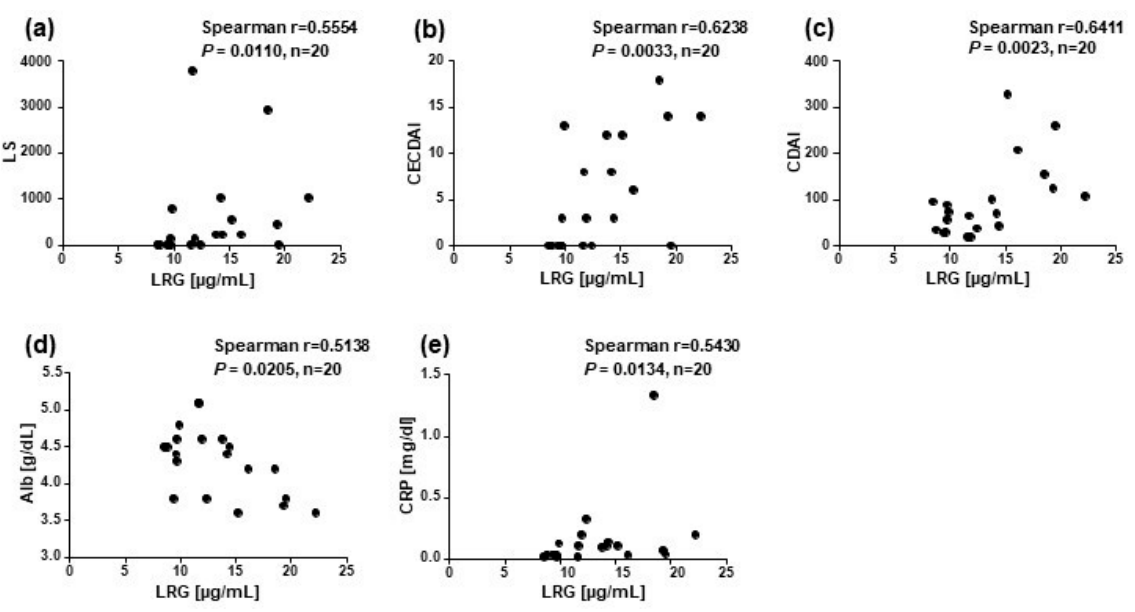
Figure 4. Correlations between the LRG levels and Crohn’s disease activity markers. The correla- tions between the LRG level and ( a ) LS, ( b ) CECDAI score, ( c ) CDAI score, ( d ) Alb level, and ( e ) CRP level were examined (n = 20); P - value is the result by Spearman’s correlation coefficient.